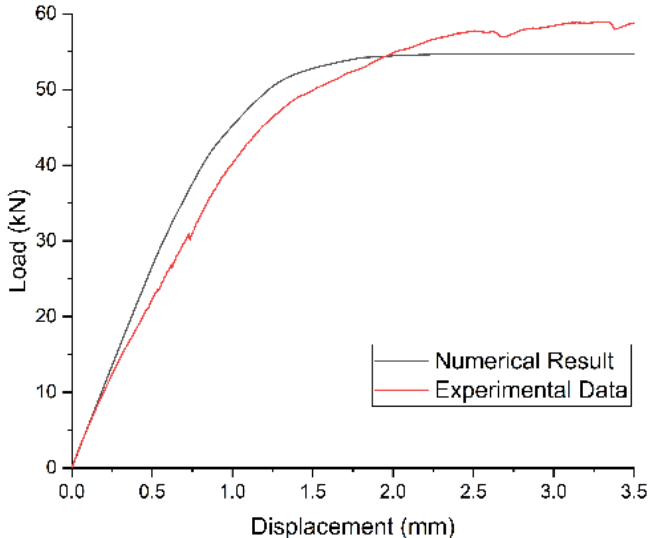
Figure 15. Comparison of the predicted and experimental load–displacement responses of the bolted joint.